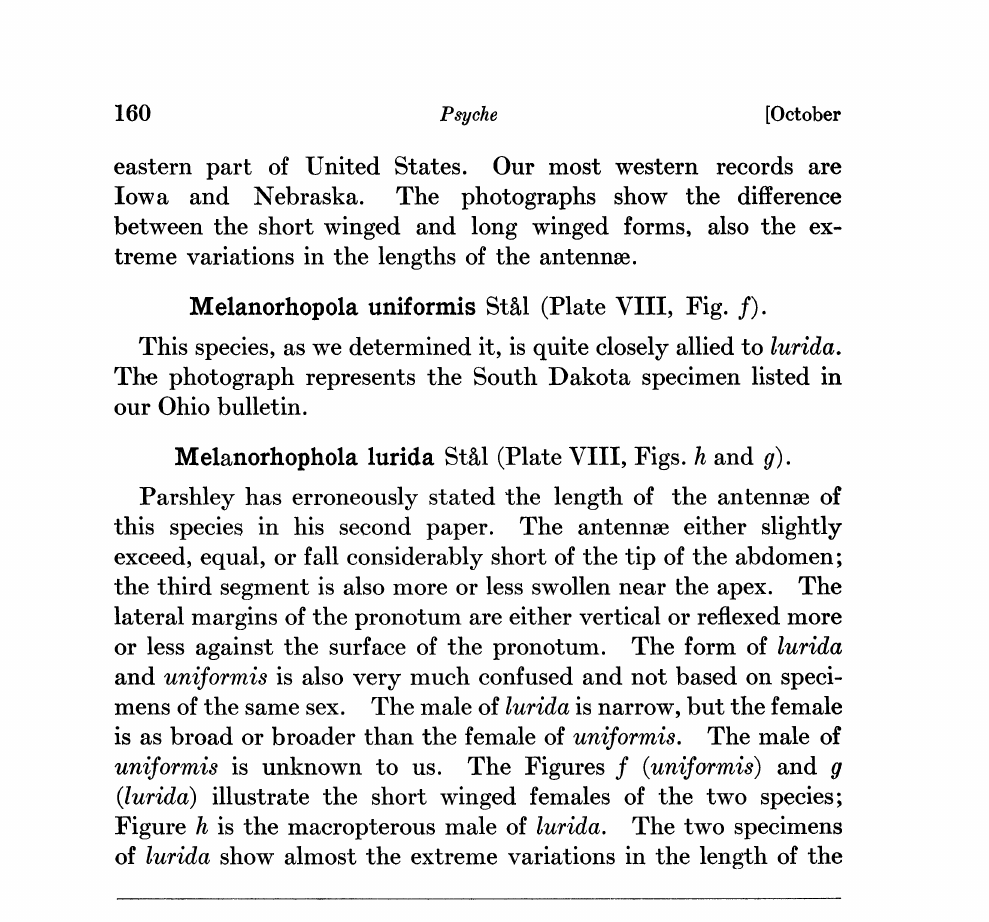
Figs. a, b, and c. Melanorophola clavata St1 (a, macropterous female; b and c, brachypterous females, the latter with short antennae). Fig. d. Fenestrella ovata Osborn and Drake (type greatly en- larged). Fig. e. Melanorophola duryi Osborn and Drake (type). Fig. f. Melanorophola uniformis St1 (brachypterous female). Figs. g and h. Melanorophola lurida St1 (g, brachypterous female with short antennae; h. macropterous male with long an-